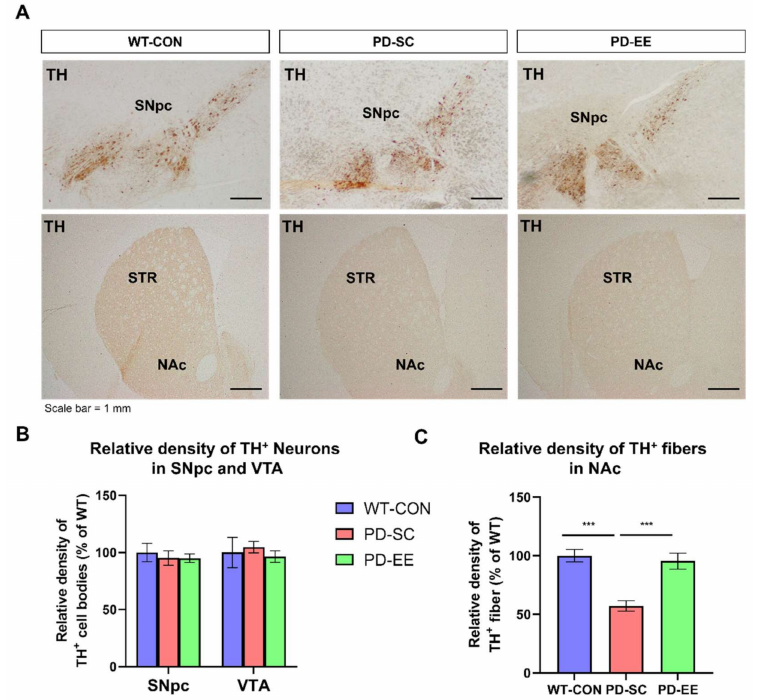
Figure 2. EE prevents the degeneration of dopaminergic nerve terminals in the nucleus accumbens (NAc) of hA53T alpha-synuclein ( α -Syn) mice. ( A ) Representative images of tyrosine hydroxylase (TH)-positive cells in substantia nigra pars compacta (SNpc) and ventral tegmental area (VTA) in the three groups (scale bar = 1 mm). ( B ) Relative density of TH-positive cells in the SNpc and VTA (SNpc: WT control group (WT-CON), n = 8; PD-SC, n = 7; PD-EE, n = 3 and VTA: WT- CON, n = 5; PD-SC, n = 3; PD-EE, n = 3). ( C ) Relative density of TH-positive dopaminergic nerve terminals in the NAc ( n = 5, each). *** p < 0.001 versus WT- CON; one-way ANOVA followed by post-hoc comparison. Data in all panels represent the mean ±